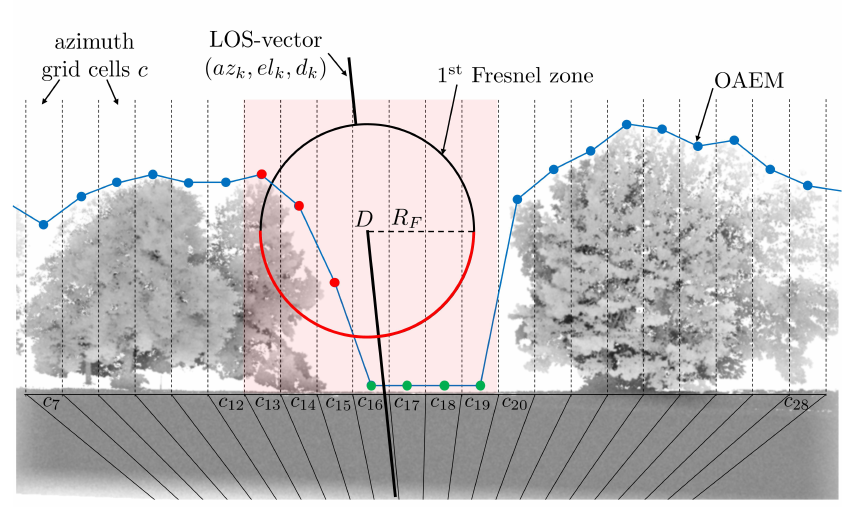
Figure 12. Diffraction identification using the Fresnel zone. The Obstruction Adaptive Elevation Mask (OAEM) is represented by the elevation angles (blue dotted line) and the respective azimuth grid cells c . The half red and half black circle represent the first Fresnel zone with radius R F determined for point D on the direct signal path along the LOS-vector, which is represented by the azimuth, elevation and distance to satellite k . The red shaded cells indicate an overlap with the Fresnel zone, and the red and green dots denote whether the elevation angles of points on the red semicircle are lower than the OAEM or not.